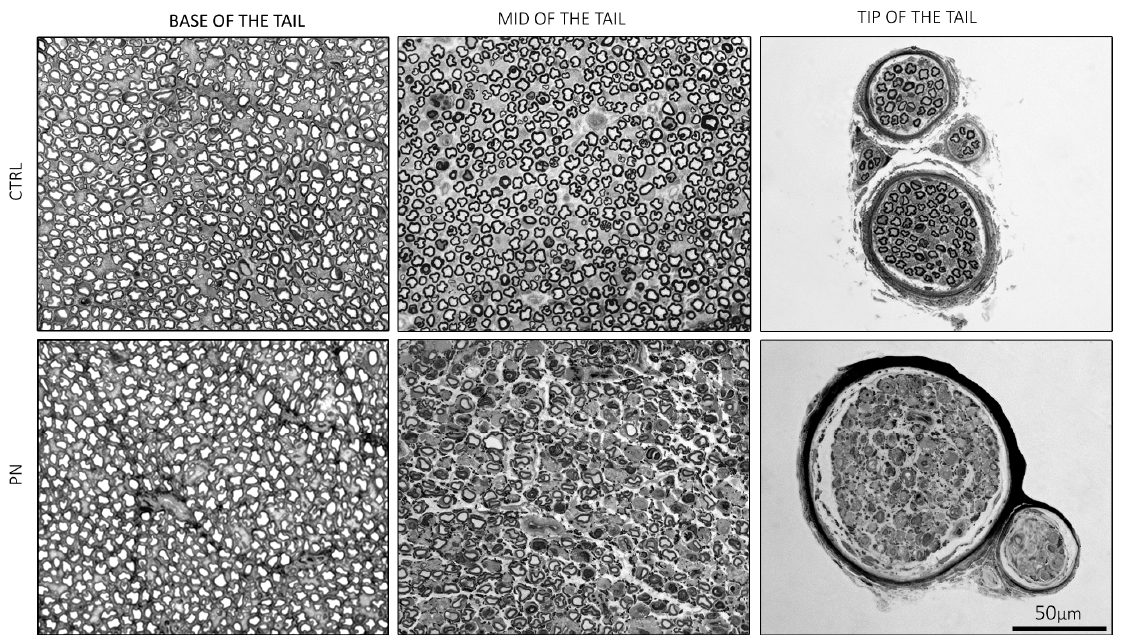
Figure 5. Representative images of ventral caudal nerves specimens (toluidine blue). In the upper panel, representative images of the control (CTRL) animals, and in the bottom panel representative images of the peripheral neuropathy (PN) animals are shown. Scale bar shown in the bottom right quadrangle applies to all images. CTRL: control group; PN: peripheral neuropathy group.